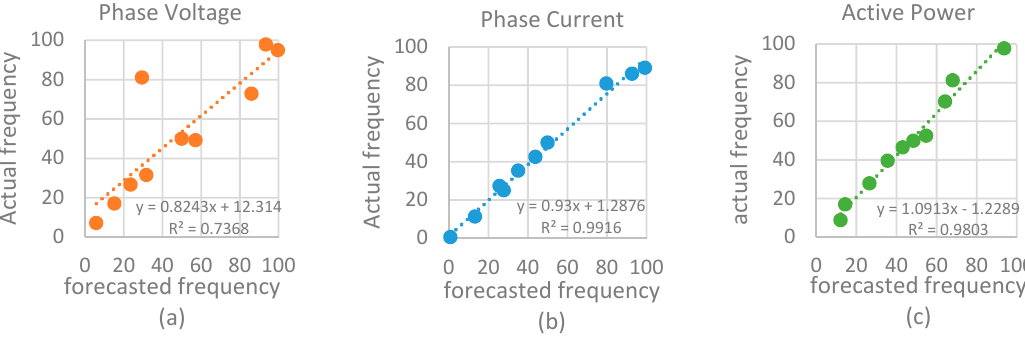
Figure 12. Analysis results of the actual value and forecast value of actual phase current, phase voltage and power based on Prony algorithm ( a ) Phase voltage; ( b ) Phase current; ( c ) Active power.